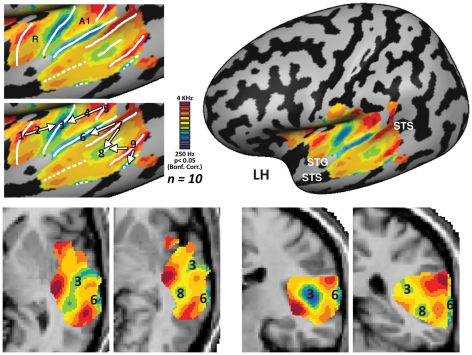
Multiple mirror-symmetric cochleotopic maps in the left hemisphere of the human auditory cortex.Group (Exp. 1, n = 10) relative frequency preference map is presented in a lateral view of the inflated left cortical hemisphere of the standard MNI brain, exposing the entire cochleotopic organization of the multiple iso-frequency bands (STG – Superior temporal gyrus, STS – Superior temporal sulcus). On the left panels, the auditory cortex region is magnified, showing Exp. 1 relative frequency preference map on the cortical surface. The estimated border between the putative mirror- symmetric cochleotopic maps is indicated (white line) in the lowest and highest frequency tones which represent the mirror-symmetry flipping lines between the homologues of A1 and R in the core auditory cortex, and between multiple additional cochleotopic fields. Numbers indicate points along the cochleotopic gradients (similar to those depicted in
Fig. 6
, from which raw time-courses of activation were sampled), with white arrows demonstrating the gradient direction in each filed. On the lower panels, the same gradients are depicted in volume views in horizontal (z = 2, −1), and coronal (y = −21, −32) slices, numbered similarly to the surface view (for demonstrative and orientation purposes only), to enable the identification of the same gradients in the three-dimensional based views.